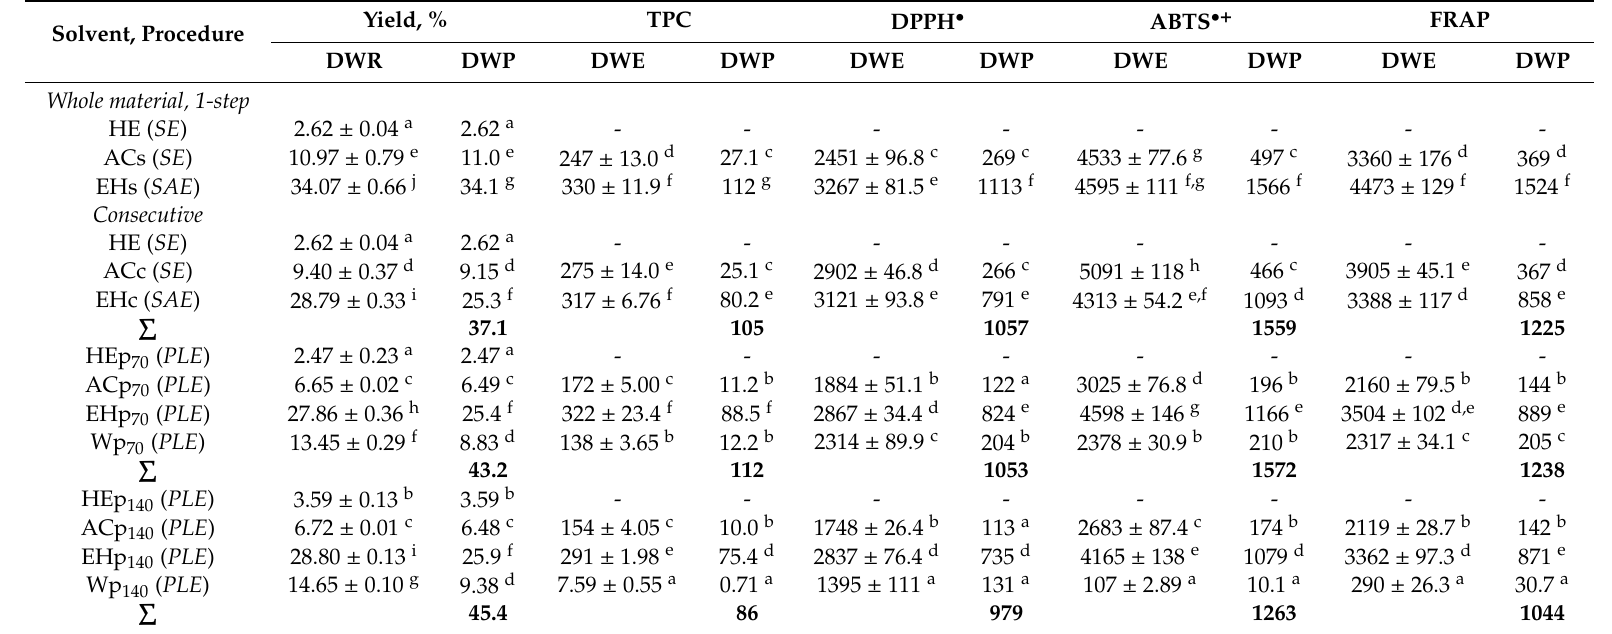
Table 1. Yield, total phenolic content (TPC) (in mg GAE / g dry weight of extract (DWE)) and antioxidant capacity (in µ M TE / g DWE) of A. theiformis extracts obtained by various solvents and extraction methods and recovery of antioxidants by various extraction processes (in mg GAE / g dry weight of the initial plant material (DWP) or µ M TE / g